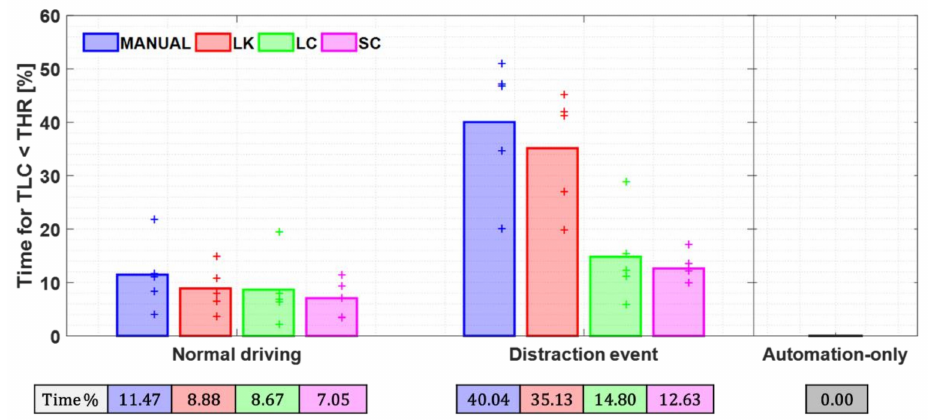
Figure 12. Safety indicators statistics (% of time under TLC-threshold).